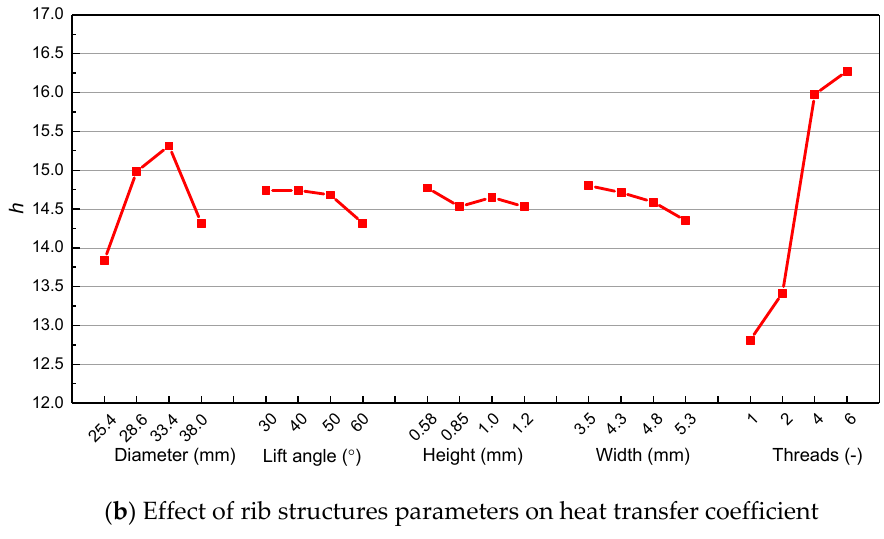
( b ) Effect of rib structures parameters on heat transfer coefficient 0.60.81.01.21.41.61.82.0